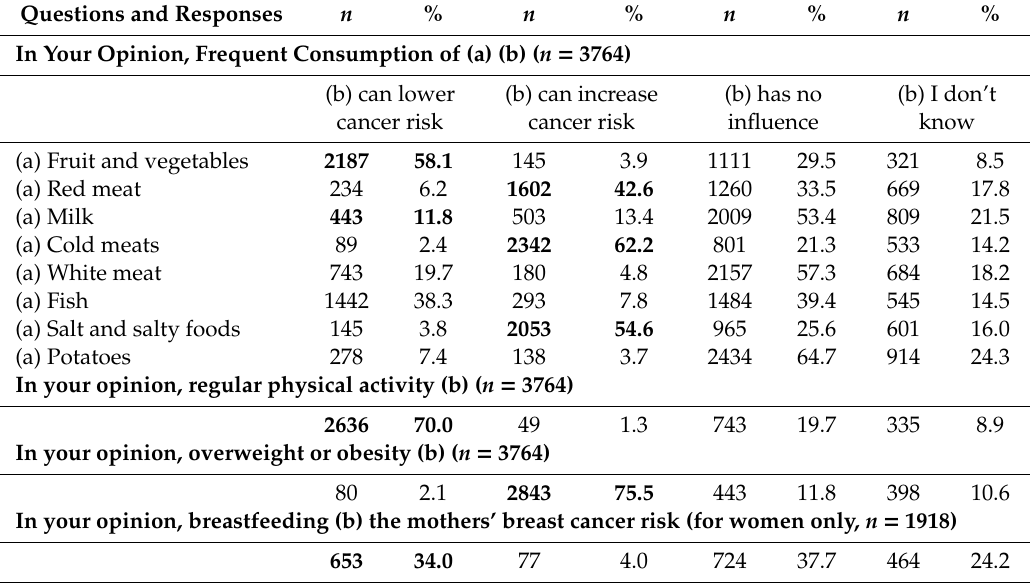
Table 4. Participant perceptions of nutritional factors and cancer risk in